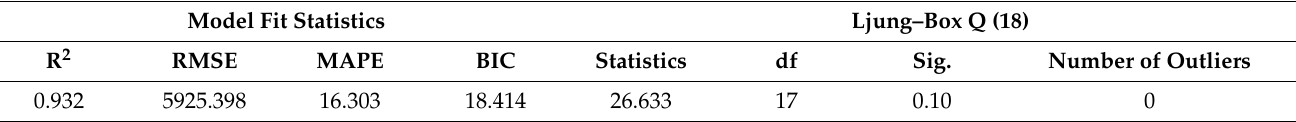
Table 5. Results of basic model-fitting parameters ARIMA (1,1,1).